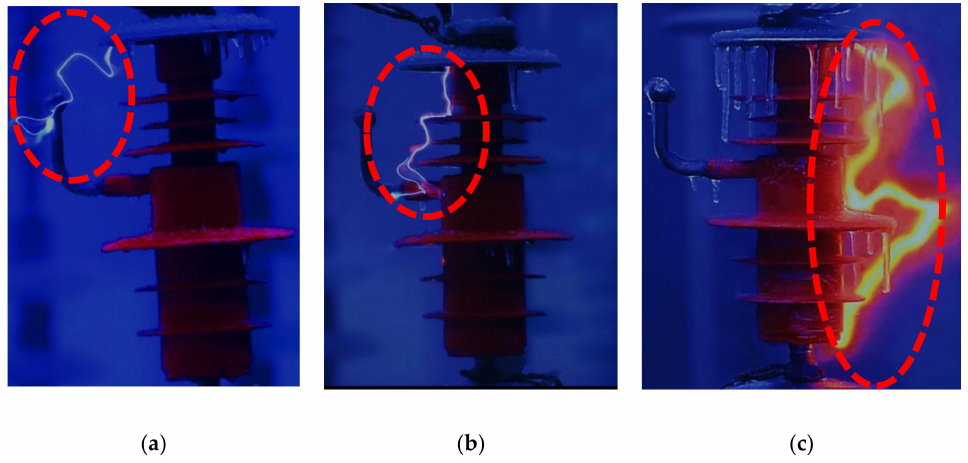
Figure 8. Different flashover arc paths: ( a ) The flashover arc path when ESDD is 0.01–0.02 mg/cm 2 ; ( b ) The flashover arc path when ESDD is 0.03–0.05 mg/cm 2 ; ( c ) The flashover arc path when ESDD is 0.07–0.15 mg/cm 2